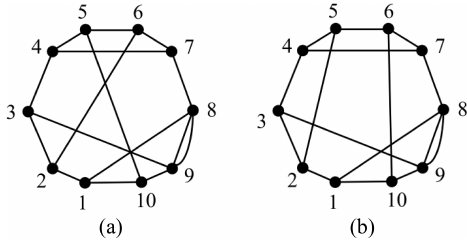
Figure 6. (a) A 10-link contracted graph (1) and (b) 10-link con- tracted graph